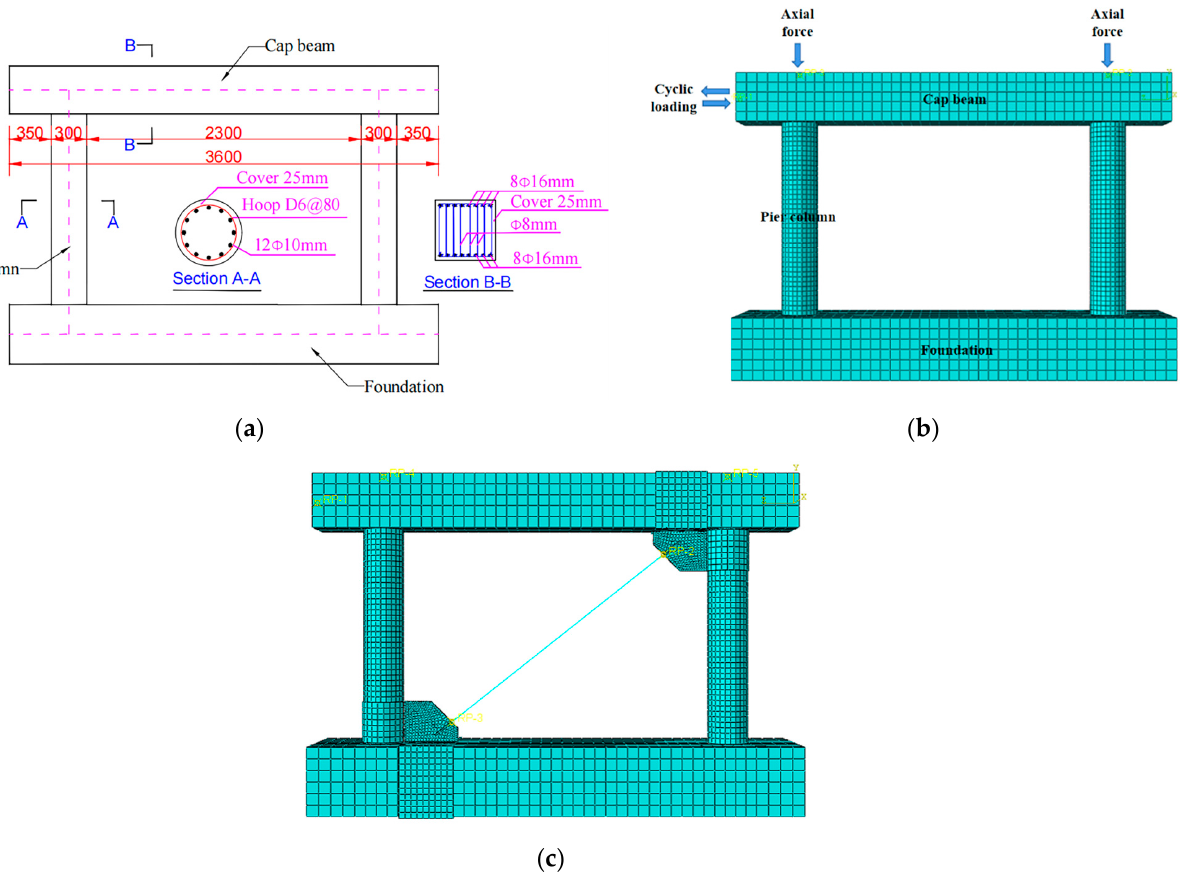
Figure 7. The benchmark model: ( a ) Details of the RC double-column bridge; ( b ) FE model of bare bridge bent; ( c ) FE model of BRB-RCB.